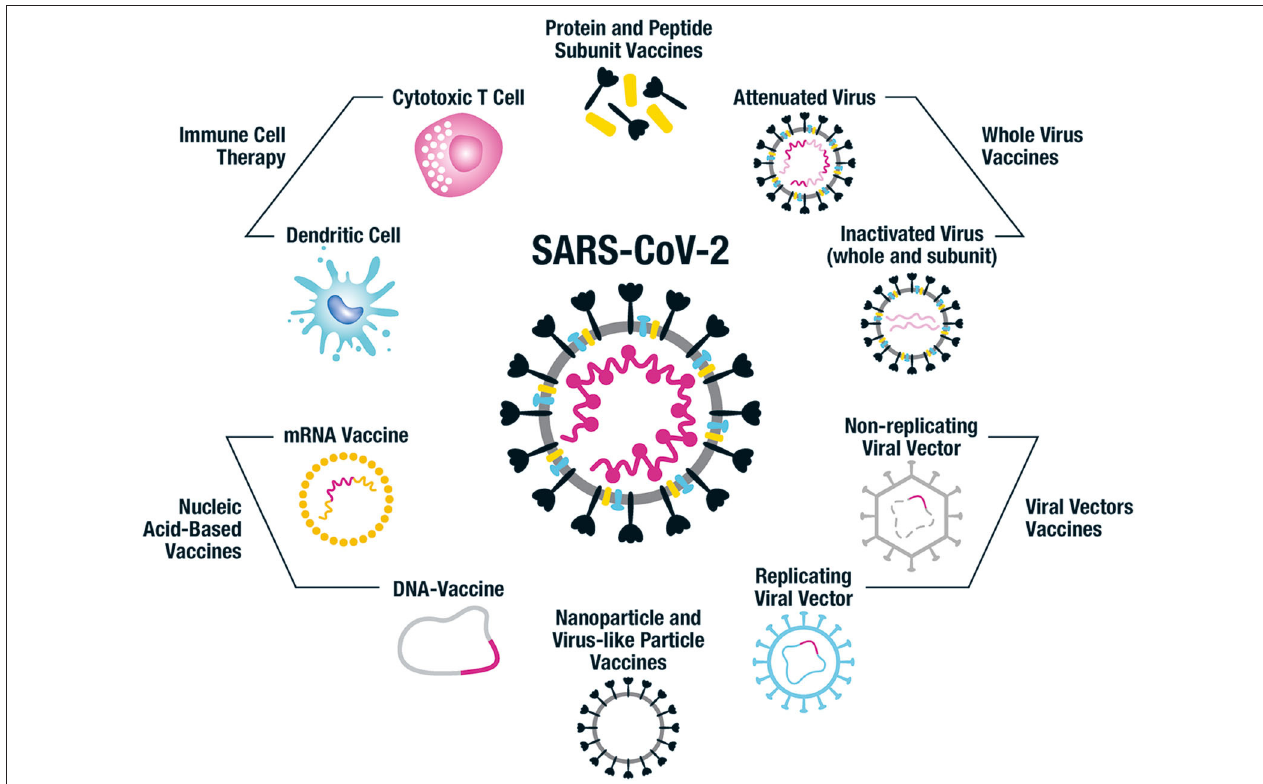
FIGURE 4 | Vaccine platforms being employed for SARS-CoV-2 vaccine design. This figure illustrates the different vaccine approaches being taken for the design of human SARS-CoV-2 vaccines. Whole virus vaccines include both attenuated and inactivated forms of the virus and subunits of inactivated virus can also be used. Protein and peptide subunit vaccines are usually combined with an adjuvant in order to enhance immunogenicity. The main emphasis in SARS-CoV-2 vaccine development has been on using the whole spike protein in its trimeric form or components of it, such as the RBD region. Multiple non-replicating viral vector vaccines have been developed, particularly focused on adenovirus; while there has been less emphasis on the replicating viral vector constructs. Nucleic acid-based approaches include DNA and mRNA vaccines, often packaged into nanocarriers such as virus-like particles (VLPs) and lipid nanoparticles (LNPs). Nanoparticle and VLP vaccines can also have antigen attached to their surface or combined in their core. The immune cell therapy approach uses genetically modified SARS-CoV-2-specific cytotoxic T cells and dendritic cells expressing viral antigens to protect against SARS-CoV-2 infection. Each of these vaccine approaches has benefits and disadvantages in terms of cost and ease of production, safety profile and immunogenicity, and it remains to be seen which of the many candidates in development protect against